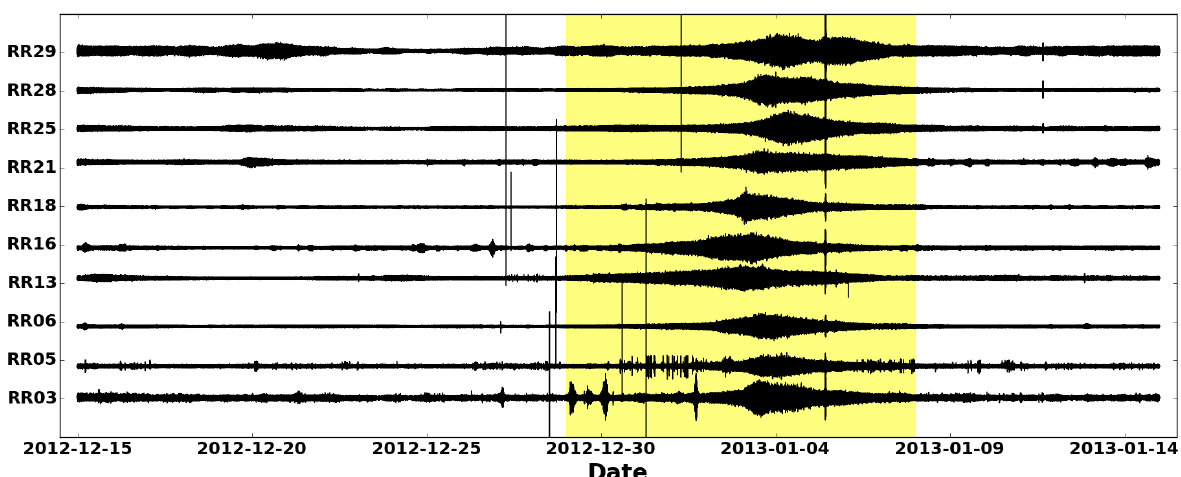
Figure 3. obspyDMT --continuous --datapath yv_continuous_dir --min_date 2012-12-15 --max_date 2013-01-15 --net YV --sta "RR0 * ,RR1 * ,RR2 * " --cha BHZ --sampling_rate 10 --data_source RESIF --user your_username --pass your_password Retrieval of continuous time series of arbitrary length, here for 30 days in 2012/2013. Data are from the temporary ocean-bottom network RHUM-RUM (network YV, station names RR*) and are currently still password-protected at the RESIF data center ( --user, --pass ). The command specifies downsampling to 10Hz immediately upon retrieval. The passage of the tropical storm Dumile is highlighted by the yellow